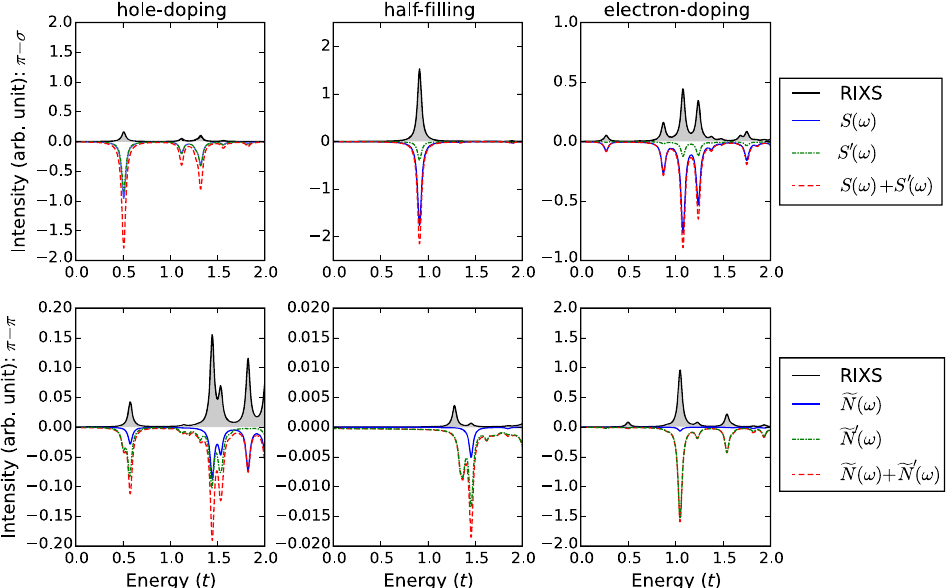
FIG. 4. Cross sections at q = ð 2 π = 3 ; 0 Þ with the elastic response removed. Top (bottom) panels show spectra for the π - σ ( π - π ) polarization. Left, middle, and right panels show RIXS spectra for n ¼ 0 . 83 , n ¼ 1 , and n ¼ 1 . 17 electron fillings, respectively. The approximate spectra are weighted with the RIXS form factors, i.e., S ð q ; ω Þ → j W π ~ N 0 ð q ; ω Þ . for S 0 ð q ; ω Þ and